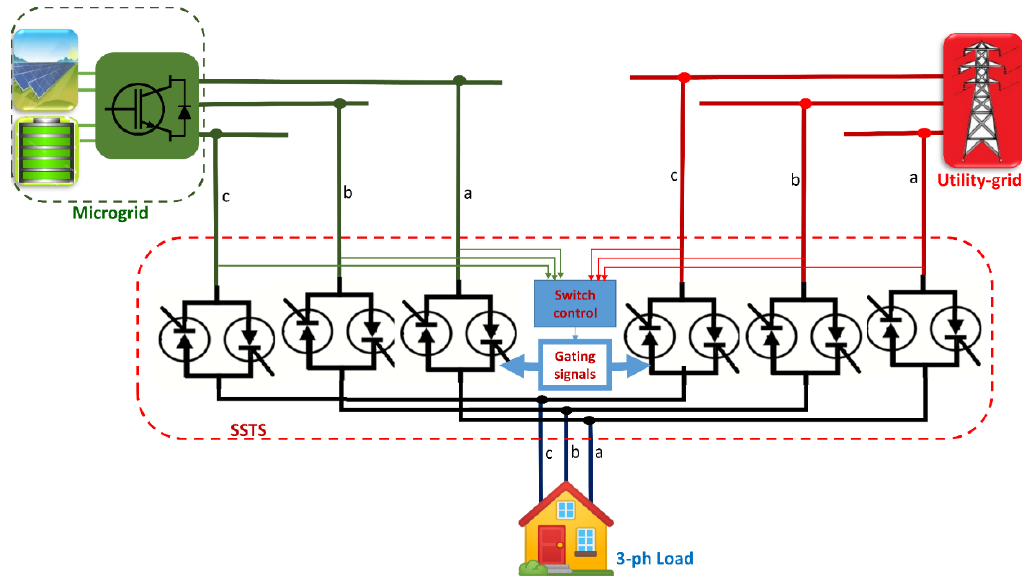
Figure 10. Schematic diagram of SSTS. Algorithm 2 Pseudocode of SSTS transfer process